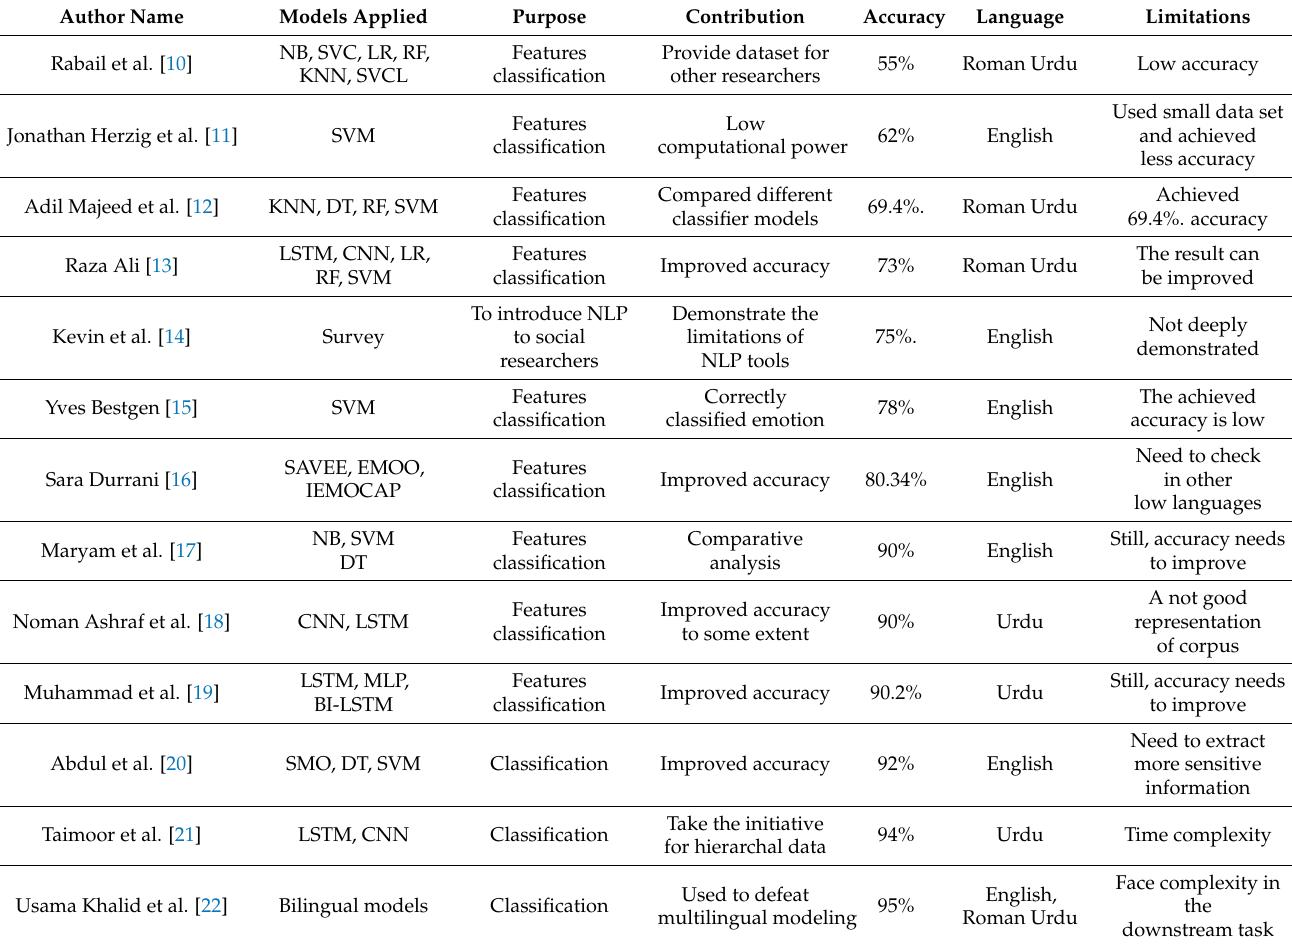
Table 1. Emotion Detection Previous Literature